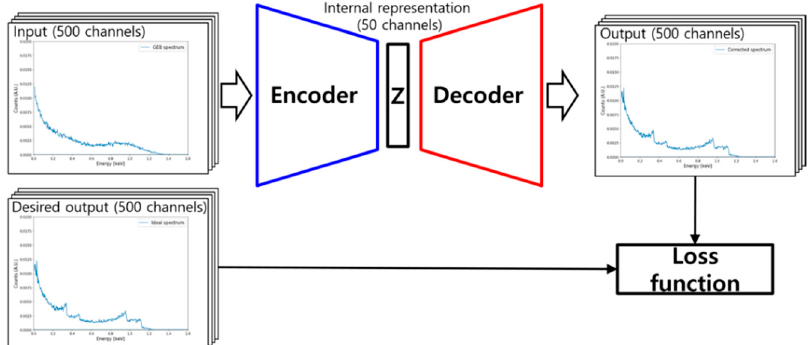
Figure 5. Training procedure of deep autoencoder.